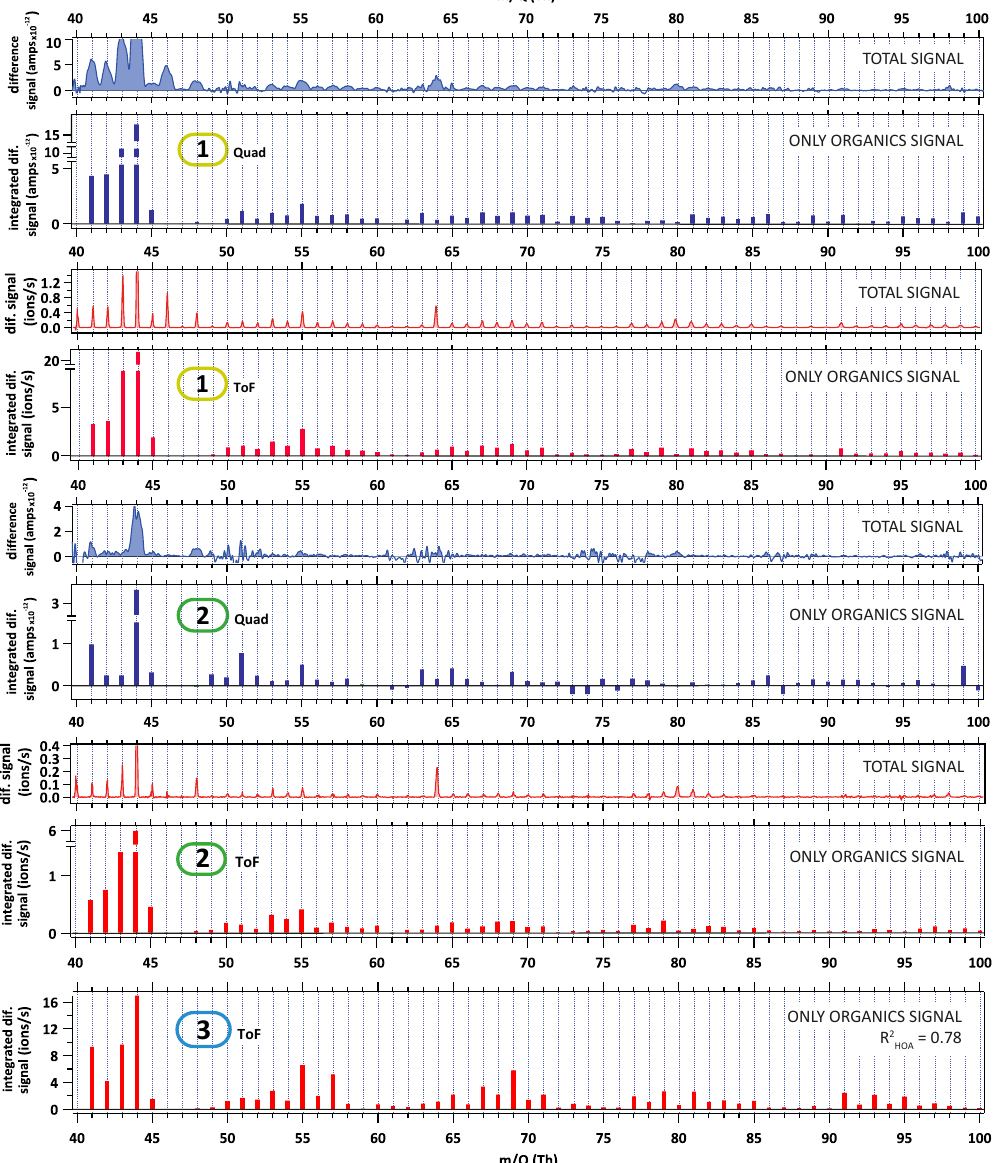
Fig. 6. Average spectra of the regions highlighted in Fig. 5. The spectra are grouped into four pairs of raw difference spectrum (calculated from the difference between the unfiltered and filtered raw spectrum) and the corresponding integrated UMR stick spectrum. The raw difference spectra show the total signal while the UMR stick spectra only show the organic fraction. Spectra recorded with the Q-ACSM are shown in blue and ToF-ACSM spectra in red. The first two pairs are from the afternoon period with the higher concentrations (1), the following two pairs are from the morning period with the lower concentrations, (2) and the last (9th) spectrum is from the peak, which was only seen with the ToF-ACSM (3). Coefficients of correlation were calculated for the spectral region between m/Q = 45Th and 100Th. Between ToF-ACSM spectrum and Q-ACSM spectrum they are R 2 = 0 . 62 for case 1 and R 2 = 0 . 19 for case 2. The R 2 given in the last plot shows the correlation to a reference HOA spectrum from (Crippa et al.,